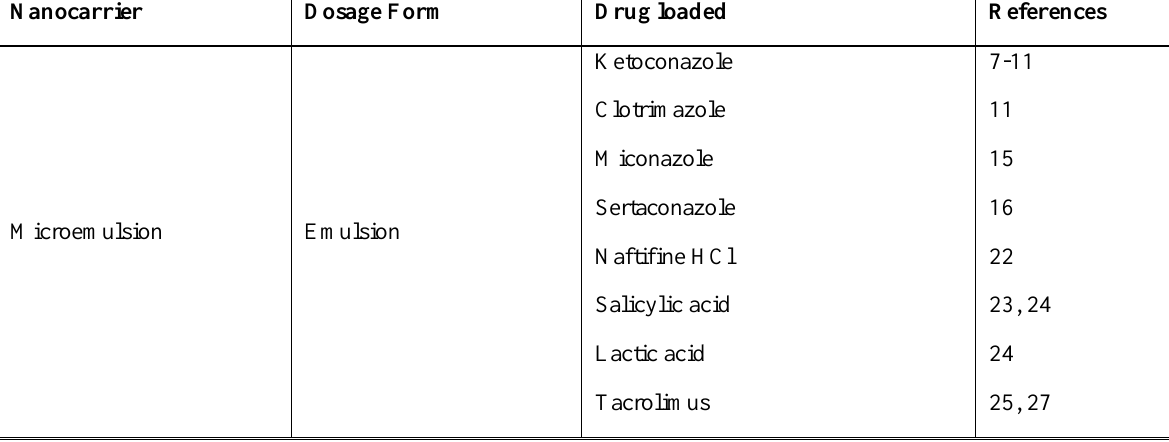
Table 2. Summary of the most common nanocarriers for skin delivery of drugs used in dandruff/SD*